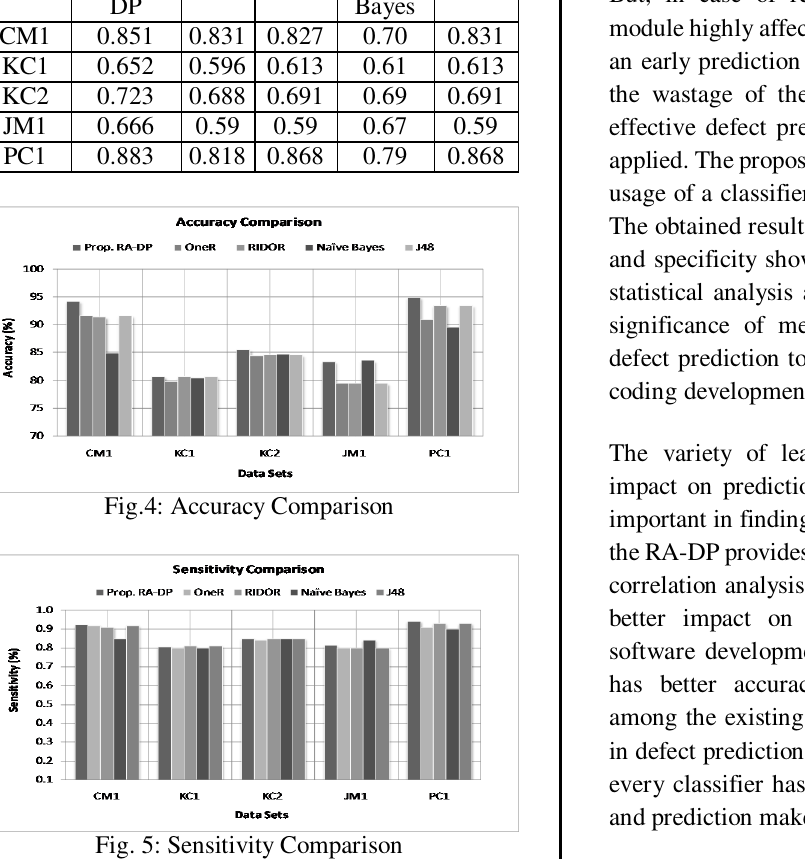
Table 5: Specificity Results Methods Prop.